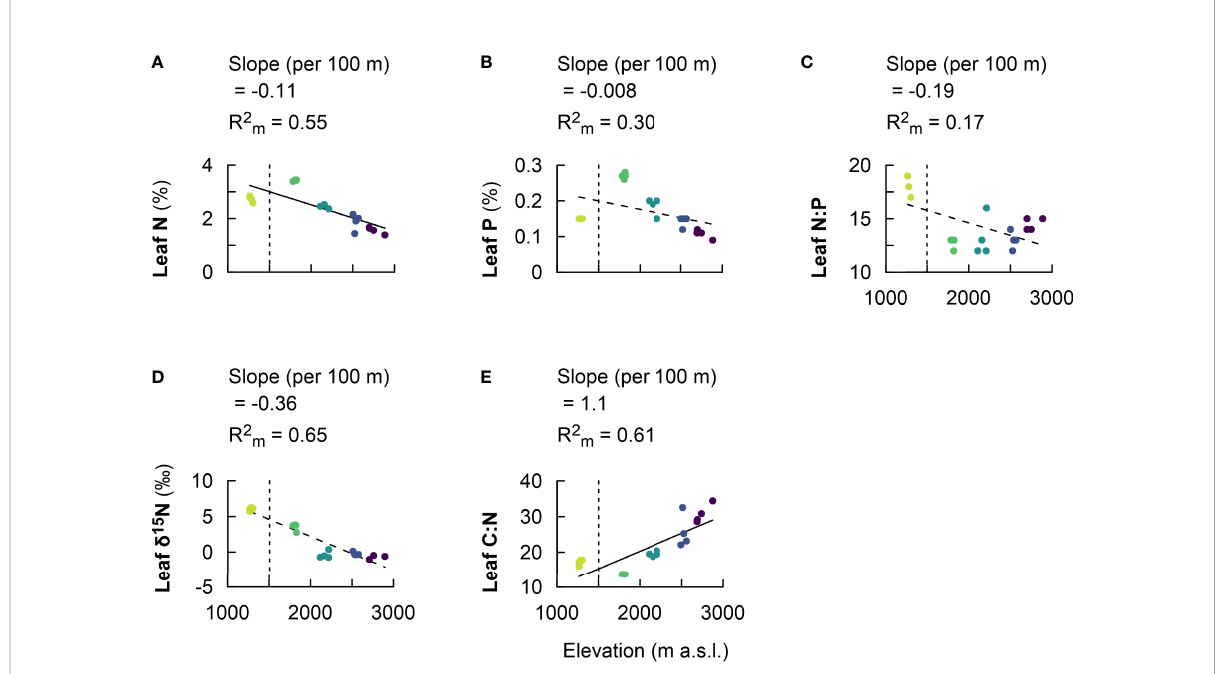
FIGURE 3 Fixed effect estimates of elevation (per 100-m elevation increase) for response parameters: leaf N (A) , leaf P (B) , leaf N:P (C) , leaf d 15 N (D) , and leaf C:N (E) . The slope of the linear mixed effect model estimates per 100 m of elevation increase is indicated (black solid line for a signi fi cant effect and black dashed line for no signi fi cant effect), as well as the marginal R 2 (R 2 m ) , representing the fraction of the response variable explained by elevation. Plots from montane forest clusters (from 1,750 to 3,000 m a.s.l.) were compared with a nearby premontane forest (separated by vertical dashed line) at an elevation of 1,250 – 1,300 m a.s.l. .